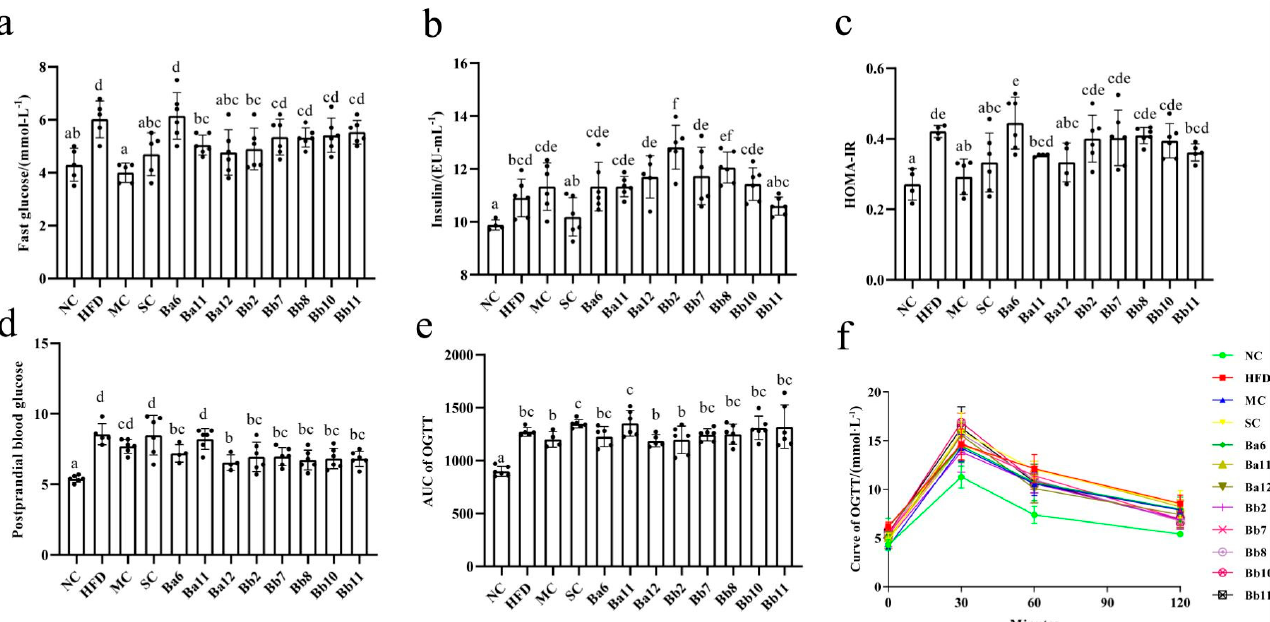
Figure 3. Effect of Bifidobacterium on blood glucose metabolism in NAFLD mice. ( a ), fasting glucose; ( b ), insulin; ( c ), HOMA ‐ IR; ( d ), postprandial blood glucose; ( e ), AUC of OGTT; ( f ), curve of OGTT. Mean values with different letters (a–e) over the bars are significantly different ( p < 0.05) according to Duncan’s multiple range test.